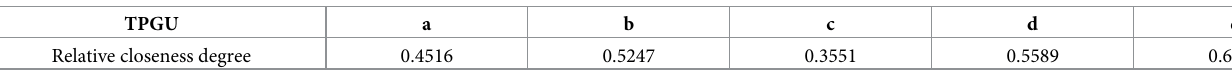
Table 8. The relative closeness degree.